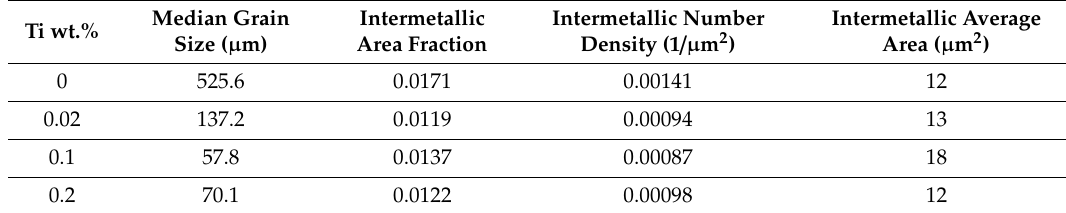
Table 2. Median grain size [ µ m] and parameters for intermetallic particle characterization for the DA2 alloy. Ti